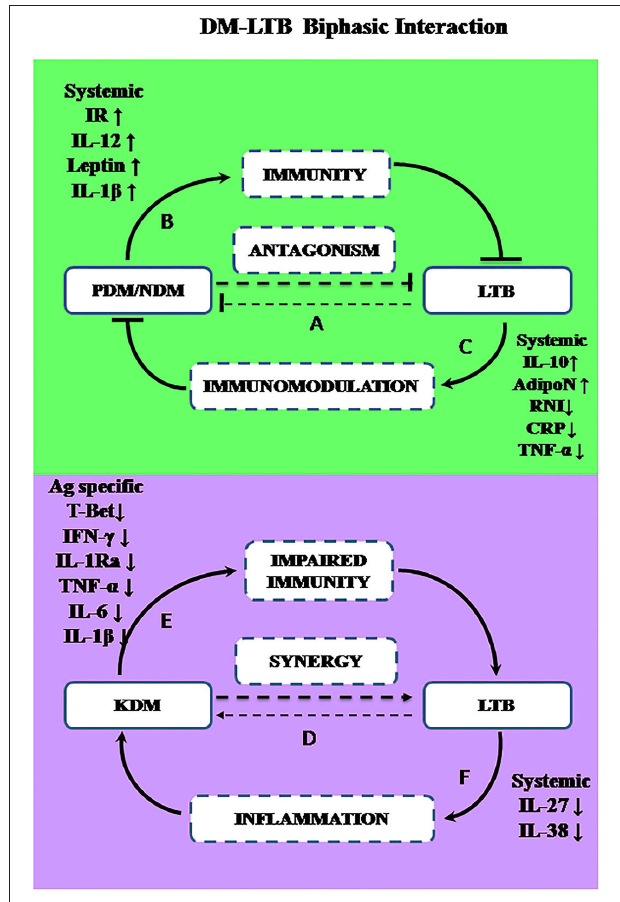
FIGURE 8 | A biphasic model showing the complex interaction between diabetes and LTBI. The prevalence of LTBI was significantly decreased in PDM and NDM stages indicating antagonism (A) . During the early stages of diabetes (PDM and NDM), increased insulin resistance and increased circulating levels of IL-1 β , IL-12, and leptin may promote immunity against LTBI (B) . Alternatively, LTBI through IL-10 mediated immunomodulation, can induce adiponectin secretion and reduce nitrite synthesis and can confer protection against diabetes (C) . However, chronic diabetes can promote LTBI infection or LTBI reactivation while LTBI can worsen glucose intolerance, indicating synergy (D) . In chronic diabetes (KDM), due to T-lymphocyte dysfunction, M.tb antigen-specific secretion of IFN- γ and T-bet expression are reduced, which can impair anti-TB immunity (E) . Alternatively, LTBI can promote inflammation by downregulation of anti-inflammatory cytokines like IL-27 and IL-38, leading to worsening of glucose tolerance (F)